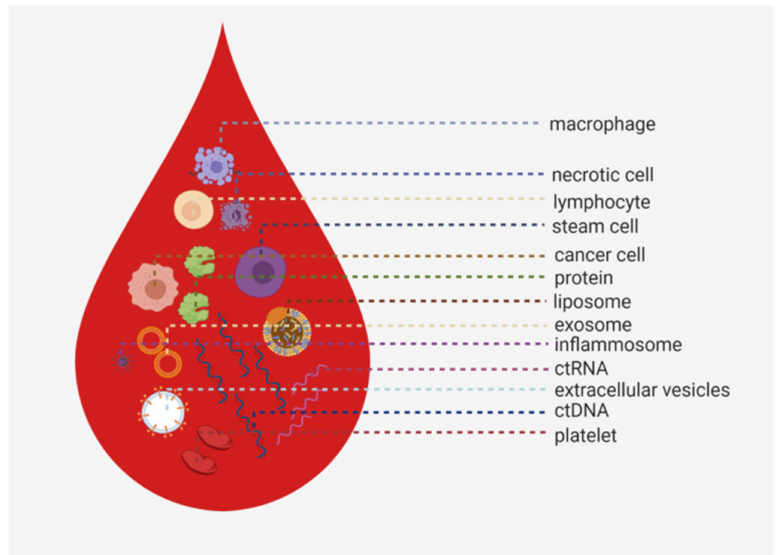
Figure 1. The “cancer world” in a drop. Here we depict the different elements found in liquid biopsy samples of cancer